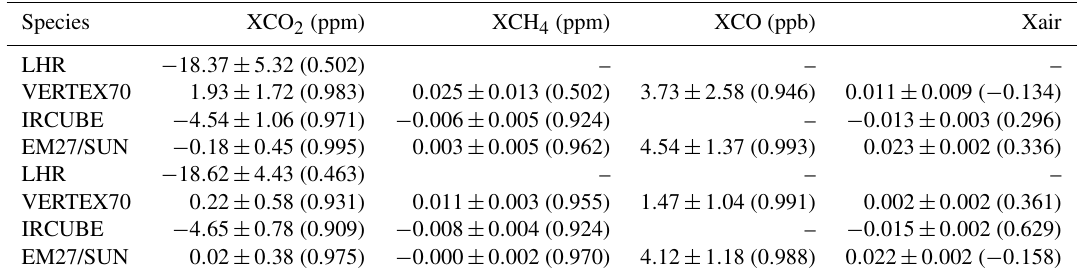
Table B1. Statistics of intercomparison results for LHR, Vertex70, IRcube, and EM27/SUN vs. TCCON for measurements performed in 2017 with SZA < 75 ◦ . The values provided are the mean bias ± the standard deviation and the correlation coefficient ( r ). The statistics in the first four rows cover the full year of measurements in 2017, while those in the last four rows are for the measurements performed between 6 July and 12 September